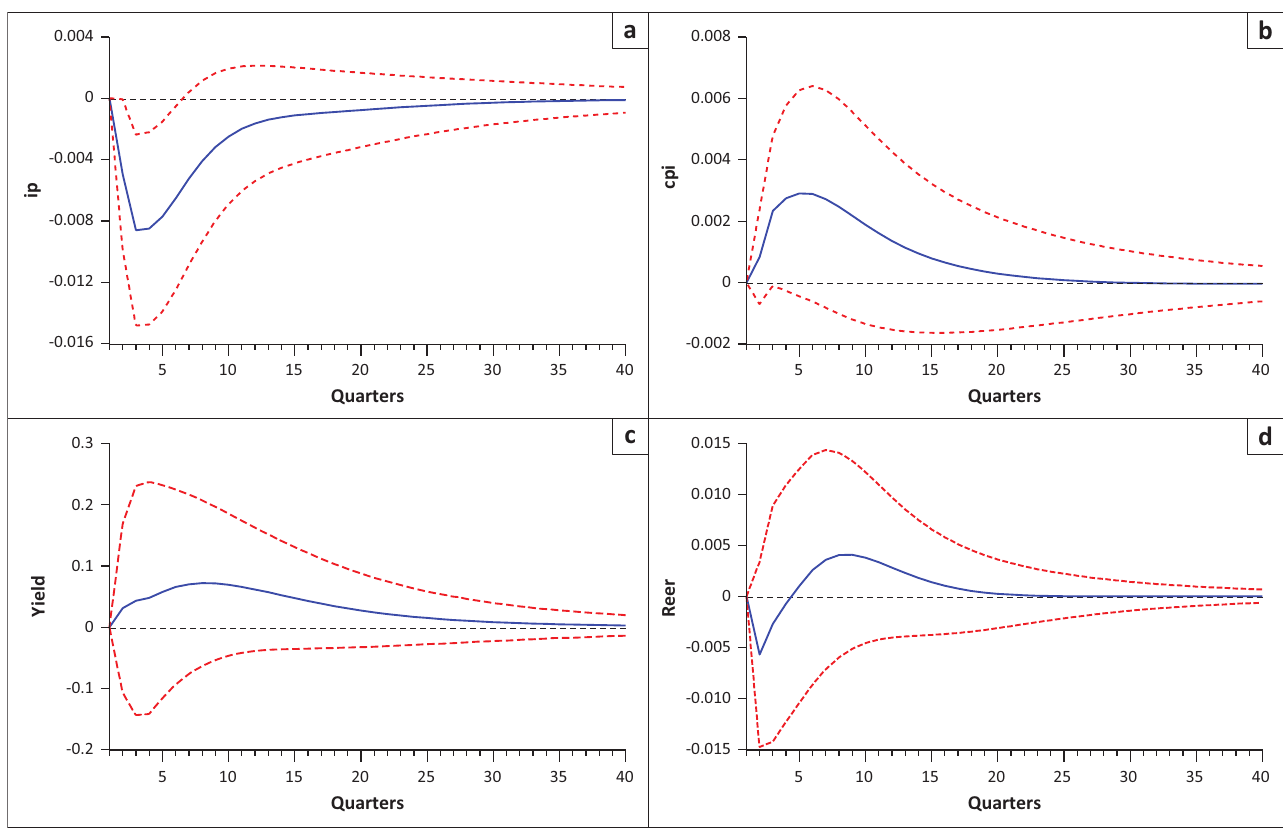
FIGURE 2: Impulse responses of selected macroeconomic variables to a positive economic policy uncertainty shock: (a) response of ip to epu; (b) response of cpi to epu; (c) response of yield to epu; (d) response of reer to